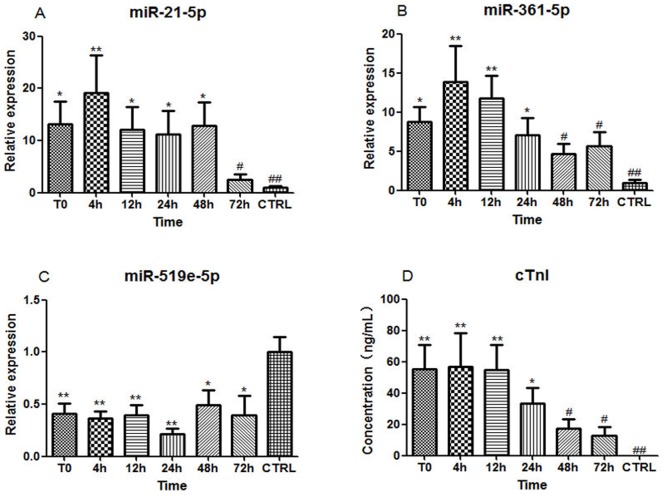
The expression levels of circulating miRNAs and cTnI in AMI patients.The dynamic expressions of circulating miRNAs and plasma cTnI in AMI patients at a time course, The initial time (T0) was 12.4±1.5 hours after the onset of AMI symptoms. (A) miR-21-5p; (B) miR-361-5p; (C) miR-519e-5p; (D) cTnI. Data are presented as mean ± SEM, *p<0.05, **p<0.01 versus healthy control; #p<0.05, ##p<0.01 versus peak level.